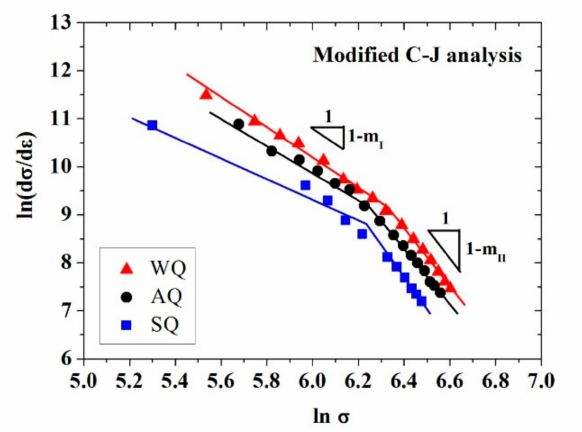
Figure 5. The modified C-J analysis of the investigated DP